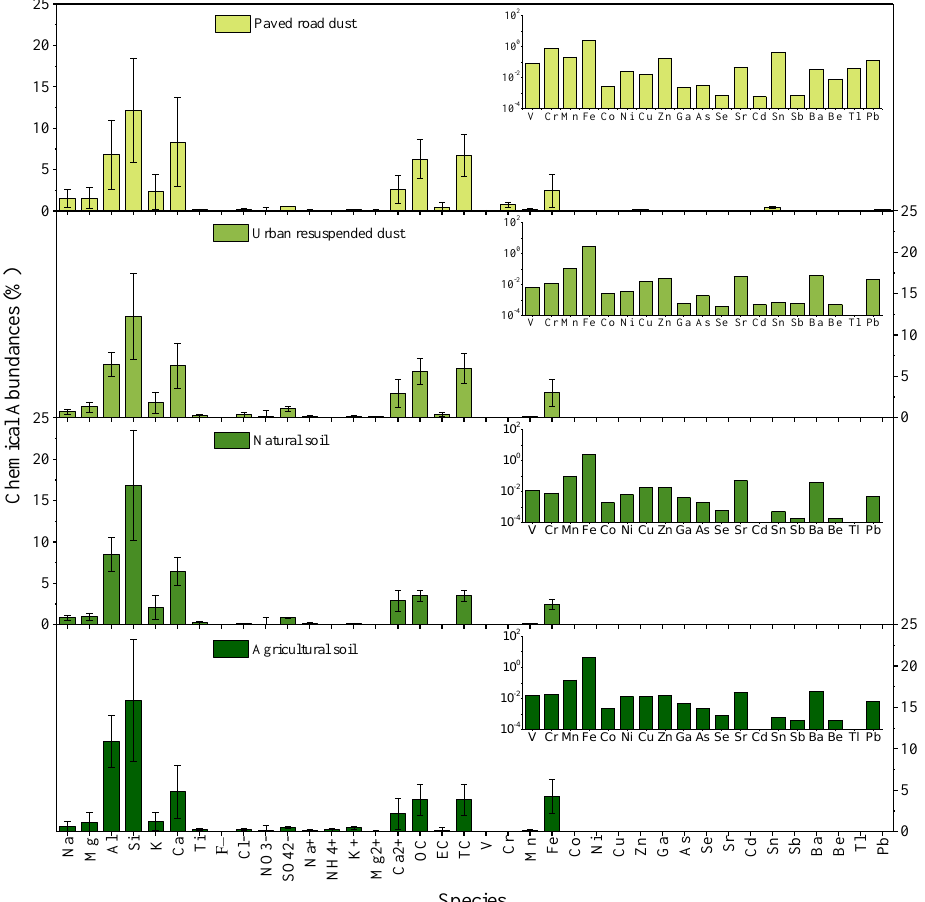
Figure 2. Geological source profiles of paved road dust, urban resuspended dust, natural soil and agricultural soil from southwestern regions of China. The height of each bar indicates the percentage of the corresponding chemical species to PM 10 . The position of each short line shows the variability in percentage composition, which includes measurement errors and source variabilities